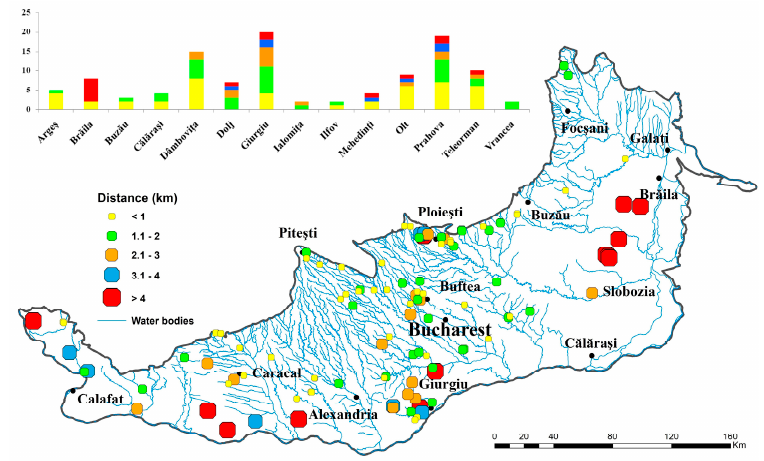
Figure 11. Distance of PV farms to water bodies.